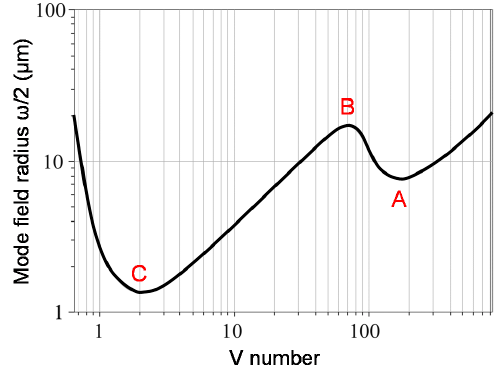
Figure 4. Dependence of the mode-field radius on the cladding V-number of a regular-sized optical fiber during the tapering process [5].